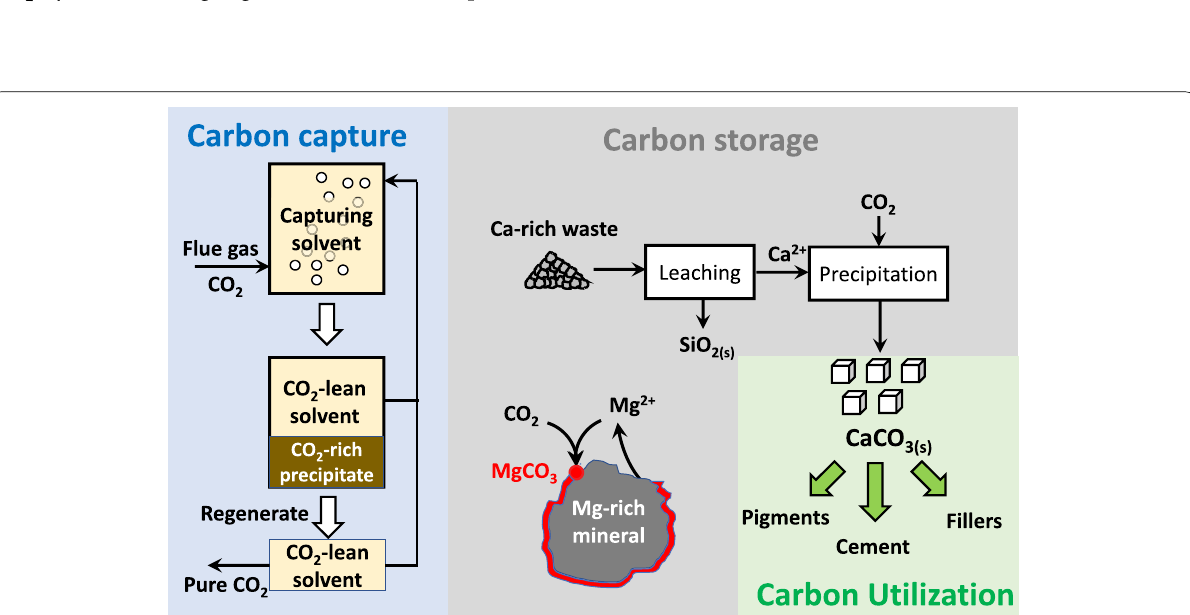
Fig. 1 Framework of this review on the role of chemical precipitation in